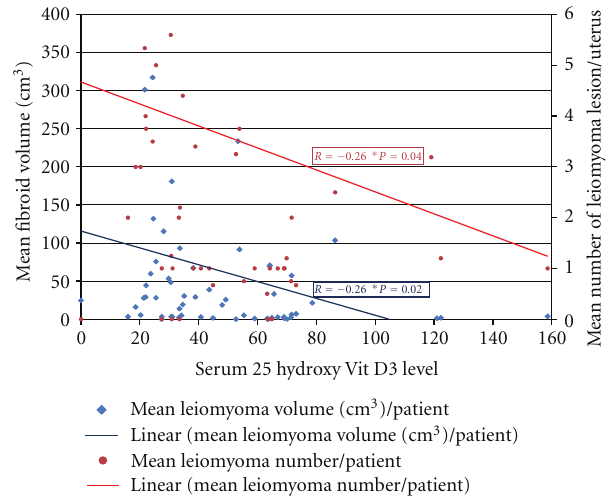
Figure 1: Serum Vitamin D3 level (nmol/L) inversely correlates with both mean volume and number of uterine